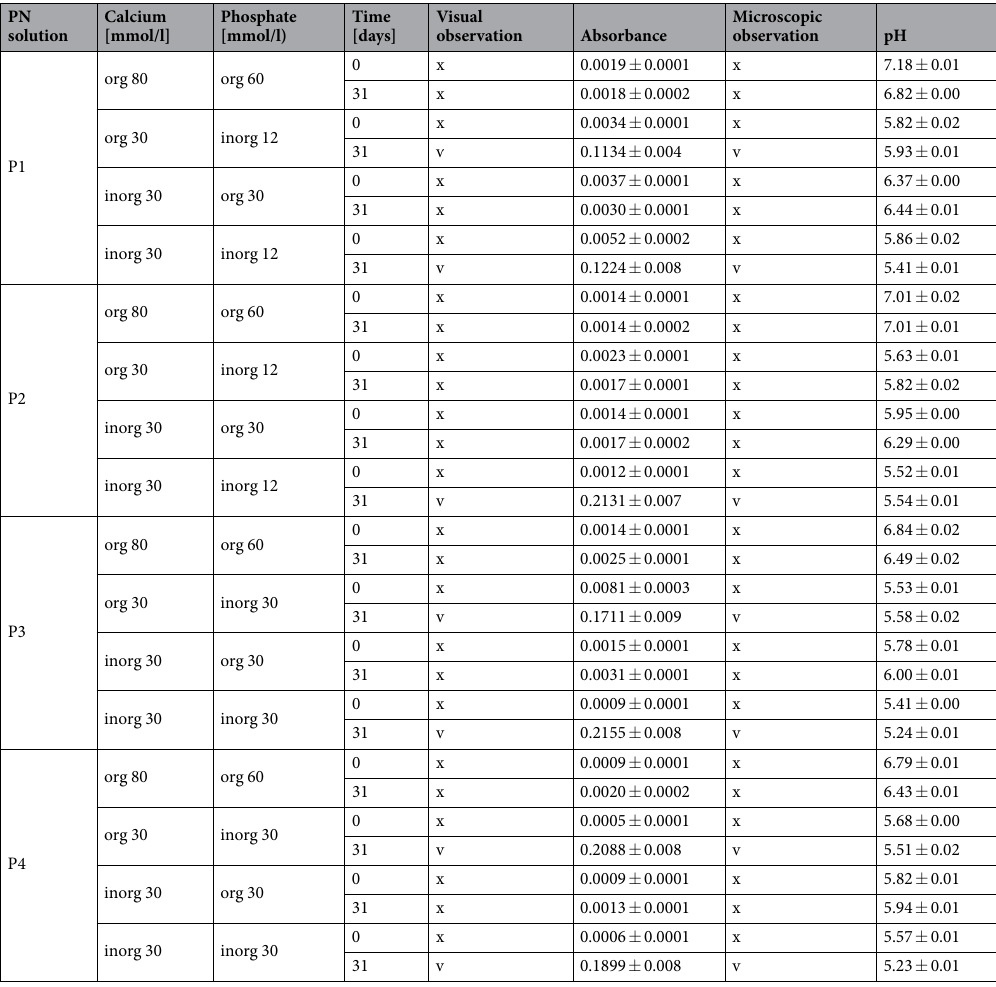
Table 1. Physicochemical Properties of PN Solution Composition P (n = 9; mean ± SD). x = no precipitation. v =